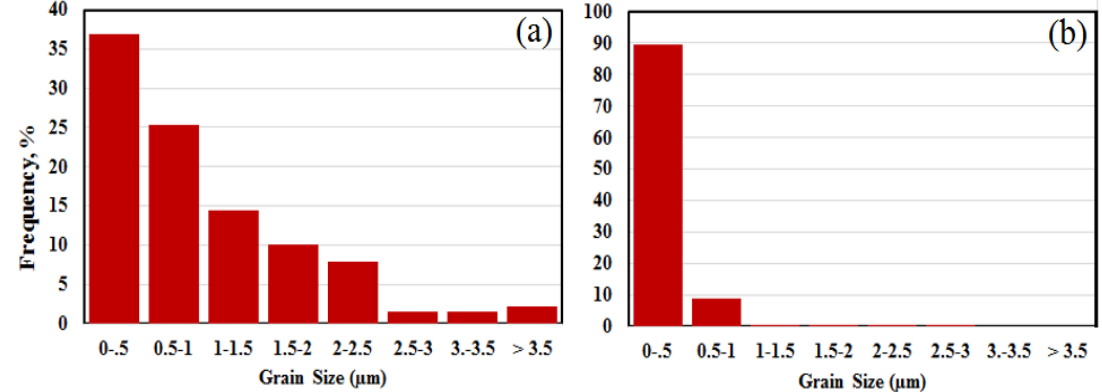
Figure 6. ( a , b ) Grain size distributions from Run 3 and Run 8, respectively, determined using EBSD data as shown in Figure 5.